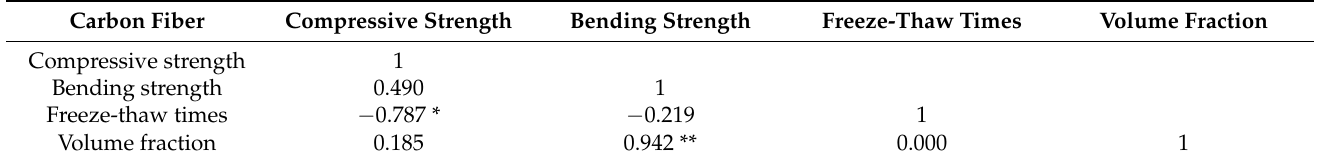
Table 9. Pearson correlation coefficient of carbon fiber cement-based materials.